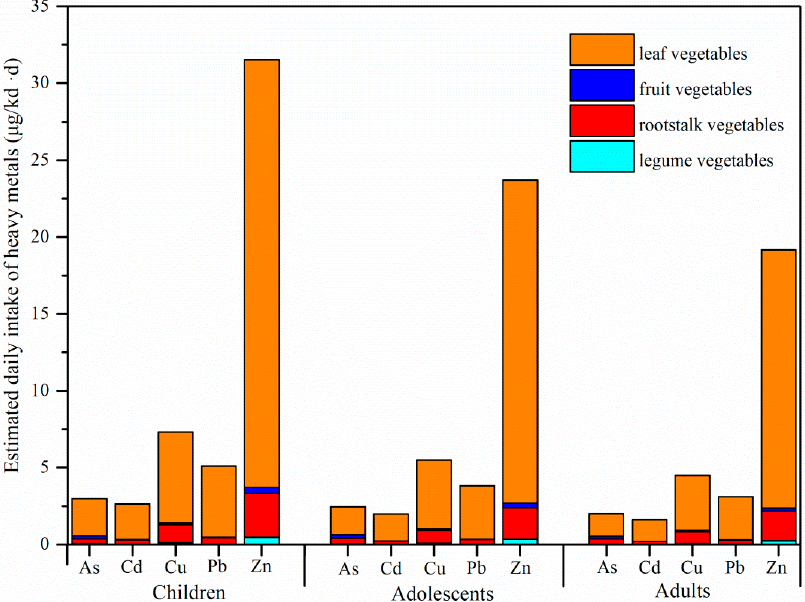
Figure 3. Daily intakes of heavy metals for children, adolescents, and adults.